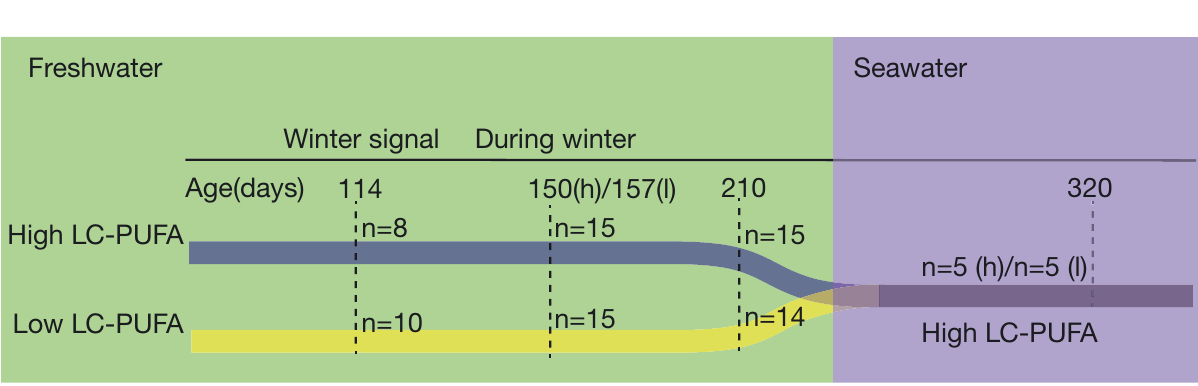
Fig. 1. Experimental design. Two tanks were used at the freshwater stage, while all fish (Salmo salar) were co-located in the same tank in seawater. Vertical dashed lines indicate sampling days. For each sampling point, the number of fish analyzed is indicated. LC-PUFA = long-chain polyunsaturated fatty acids, h = diet high in LC-PUFA, l = diet low in